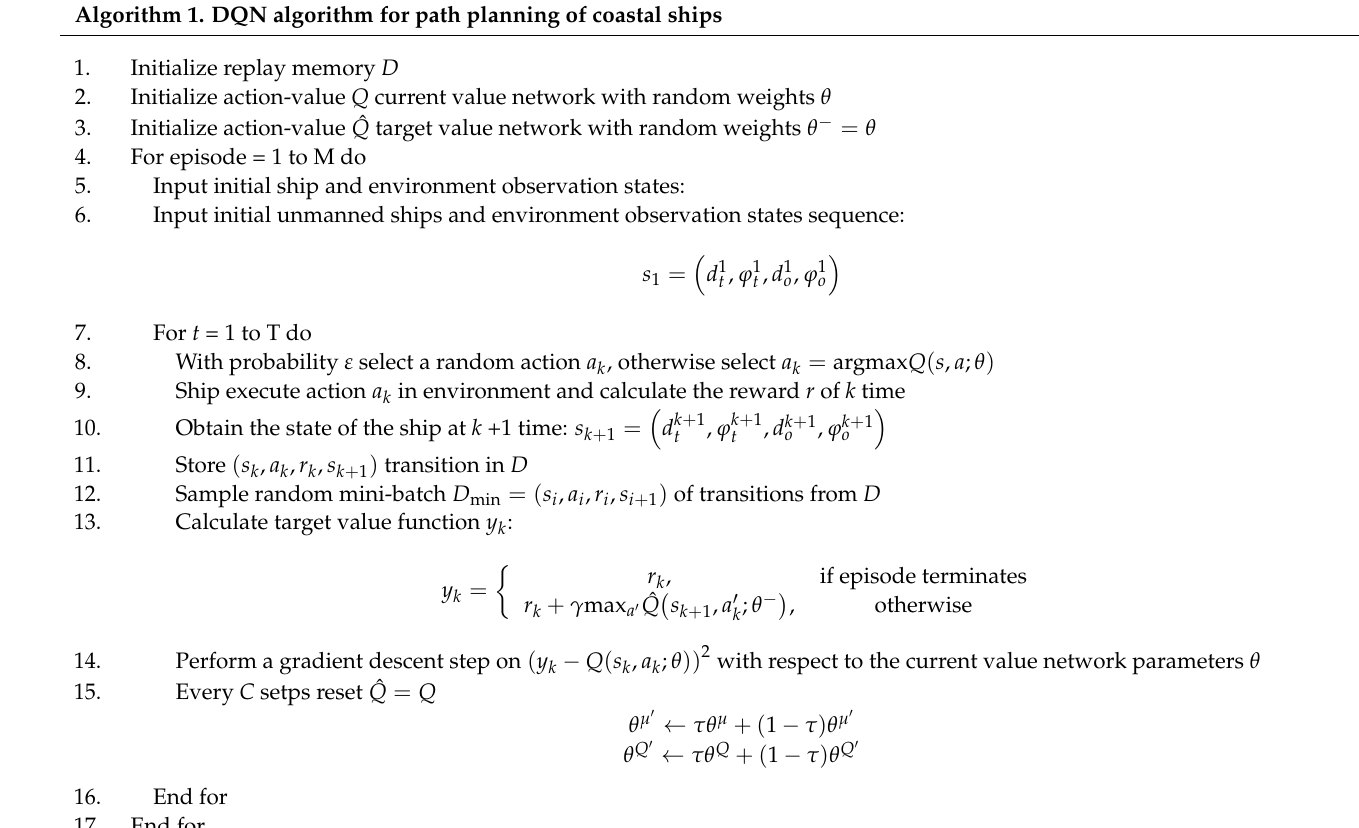
Algorithm 1. DQN algorithm for path planning of coastal